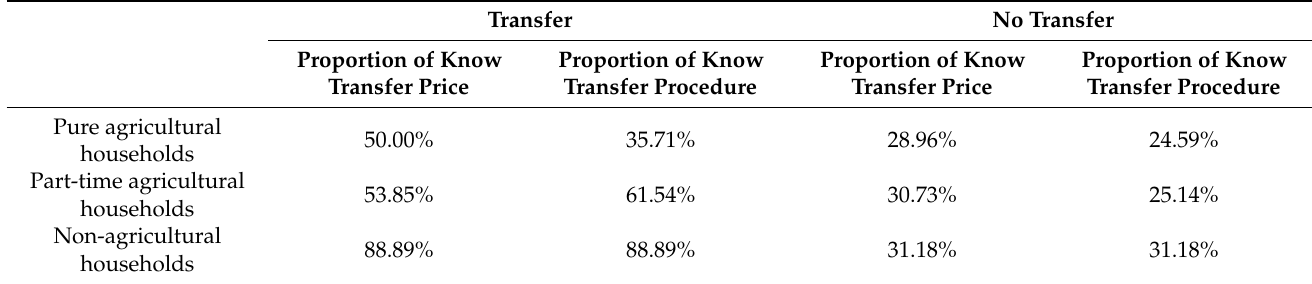
Table 8. Forestland transfer and transfer price and